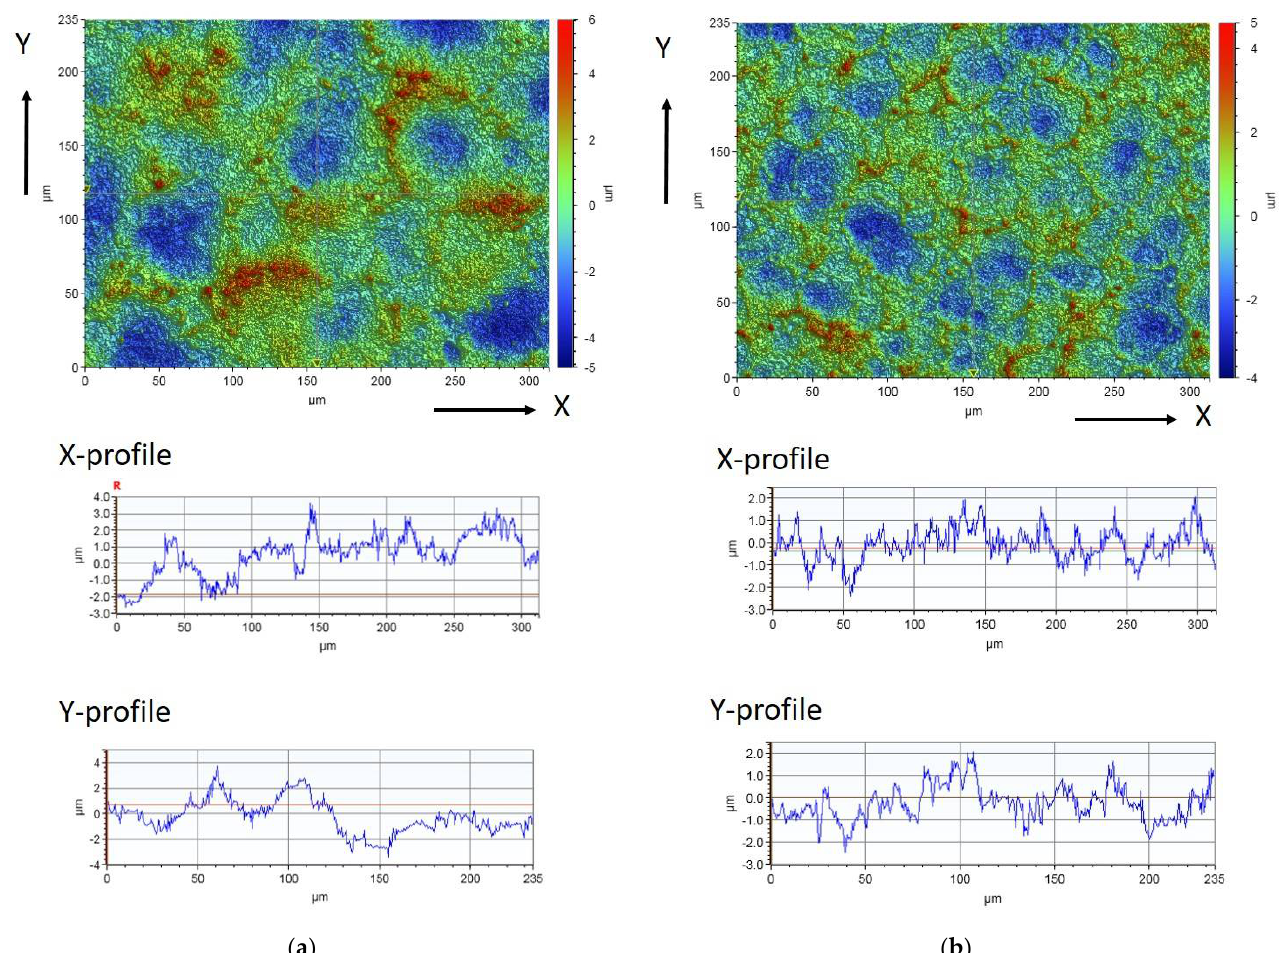
Figure 6. White light interferometry images of ED-machined surfaces of 28 WC-1400. ( a ) 28 WC-1400 machined with parameter set EDM 1. ( b ) 28 WC-1400 machined with parameter set EDM 2. Upper images show topography in areas of 235 × 315 mm² size. Different colors indicate different height levels (see axis right). Profiles below show the topography along the X-axis and Y-axis.